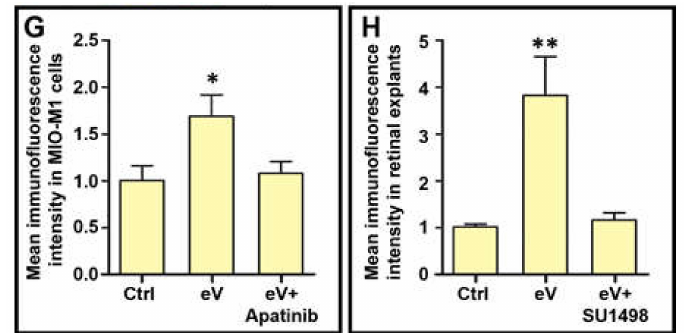
Figure 2. VEGFR2 immunofluorescence in MIO-M1 cells ( A , C , E ) and in cryostat sections of retinal explants ( B , D , F ) in Ctrl ( A , B ), in the presence of 1 ng / mL (MIO-M1 cells) or 10 ng / mL (retinal explants) of exo-VEGF ( C , D ) and in the presence of exo-VEGF with a VEGR2 blocker (0.1 µ M Apatinib for MIO-M1 cells and 25 µ M SU1498 for retinal explants: E , F ). In the images of MIO-M1 cells ( A , C , E ), above background, specific VEGFR2 immunolabeling was highlighted using Adobe Photoshop, and it appears as bright, whitish dots. Background, non-specific immunostaining is dark green. Cell nuclei were visualized with Hoechst and actin filaments with rhodamine-conjugated phalloidin. In retinal explants ( B , D , F ), specific VEGR2 immunostaining is bright green, while cell nuclei were visualized with DAPI counterstain. Putative immunolabeled blood vessels are indicated by arrows; putative immunolabeled Müller cell processes are indicated by arrowheads. GCL, ganglion cell layer; INL, inner nuclear layer; IPL, inner plexiform layer; ONL, outer nuclear layer; OPL, outer plexiform layer. Scale bars, 20 µ m. G and H indicate VEGFR2 immunofluorescence levels normalized to Ctrl in MIO-M1 cells and in retinal explants, respectively, in the di ff erent experimental conditions. eV, exo-VEGF. * p < 0.05 and ** p < 0.01 relative to Ctrl. n =